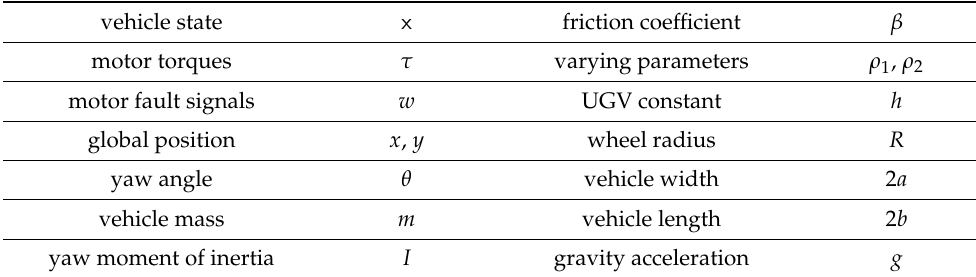
Table 1. UGV parameters. vehicle state x friction coefficient motor